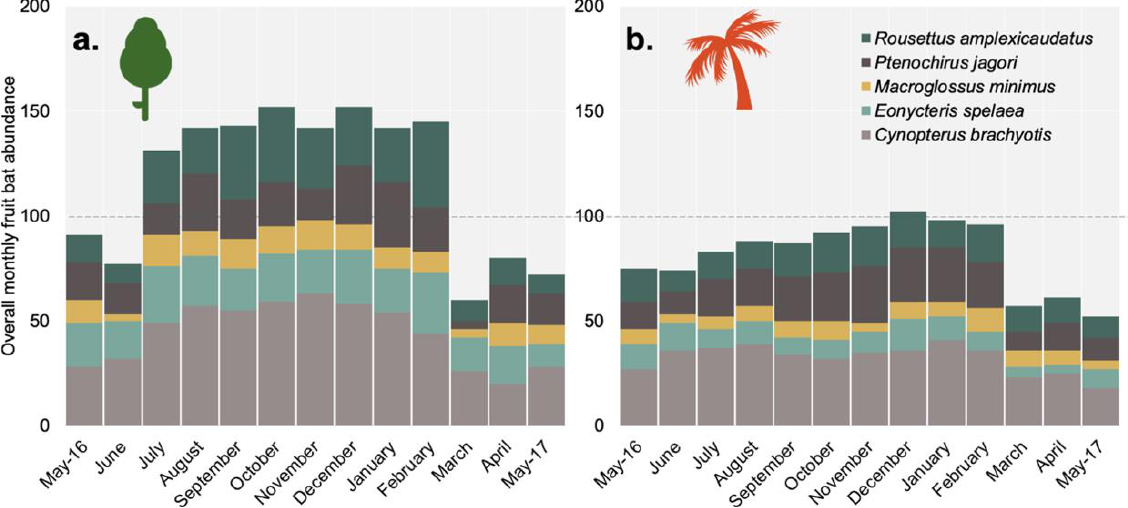
Figure 3. The species-specific proportion of overall monthly fruit bat abundance between two plantations (( a ) rubber, ( b ) oil palm).